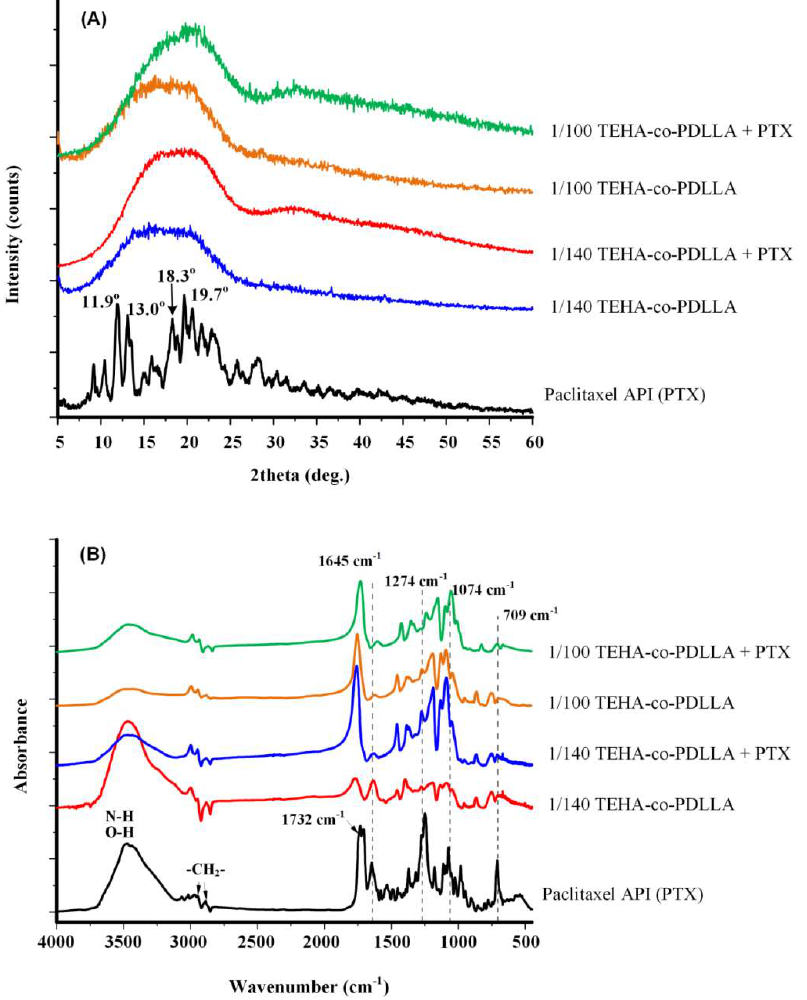
Figure 6. XRD difractograms ( A ) and FTIR spectra ( B ) of Paclitaxel and TEHA-co-PDLLA nanoparticles.